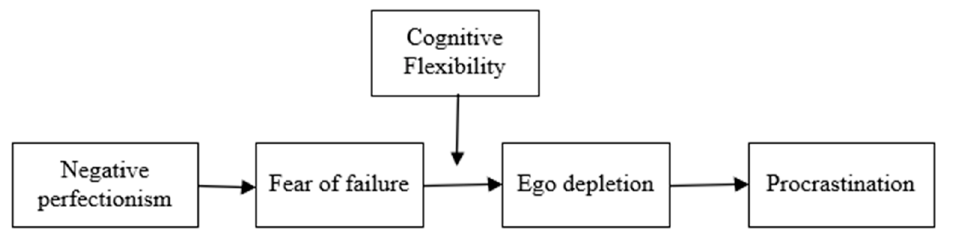
Figure 1. Theoretical model.